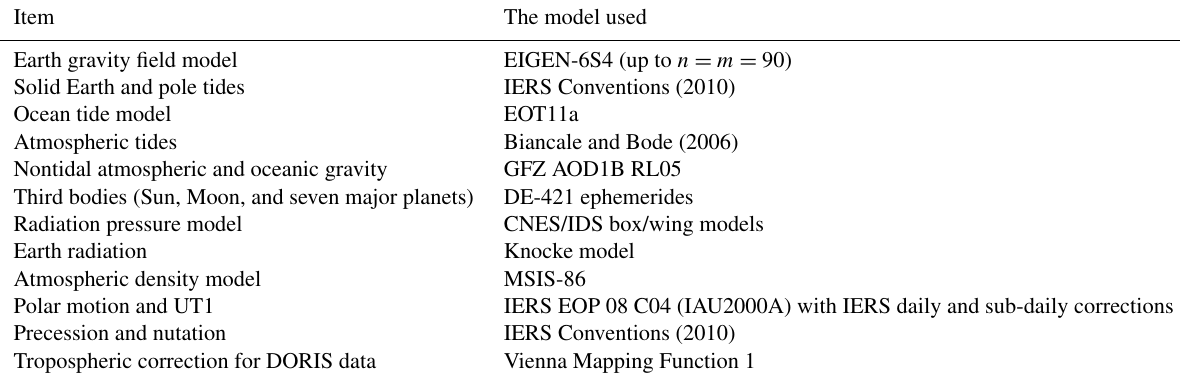
Table 2. The main models used for orbit determination (for the details and references for the models, see Rudenko et al., 2014, 2017). Item